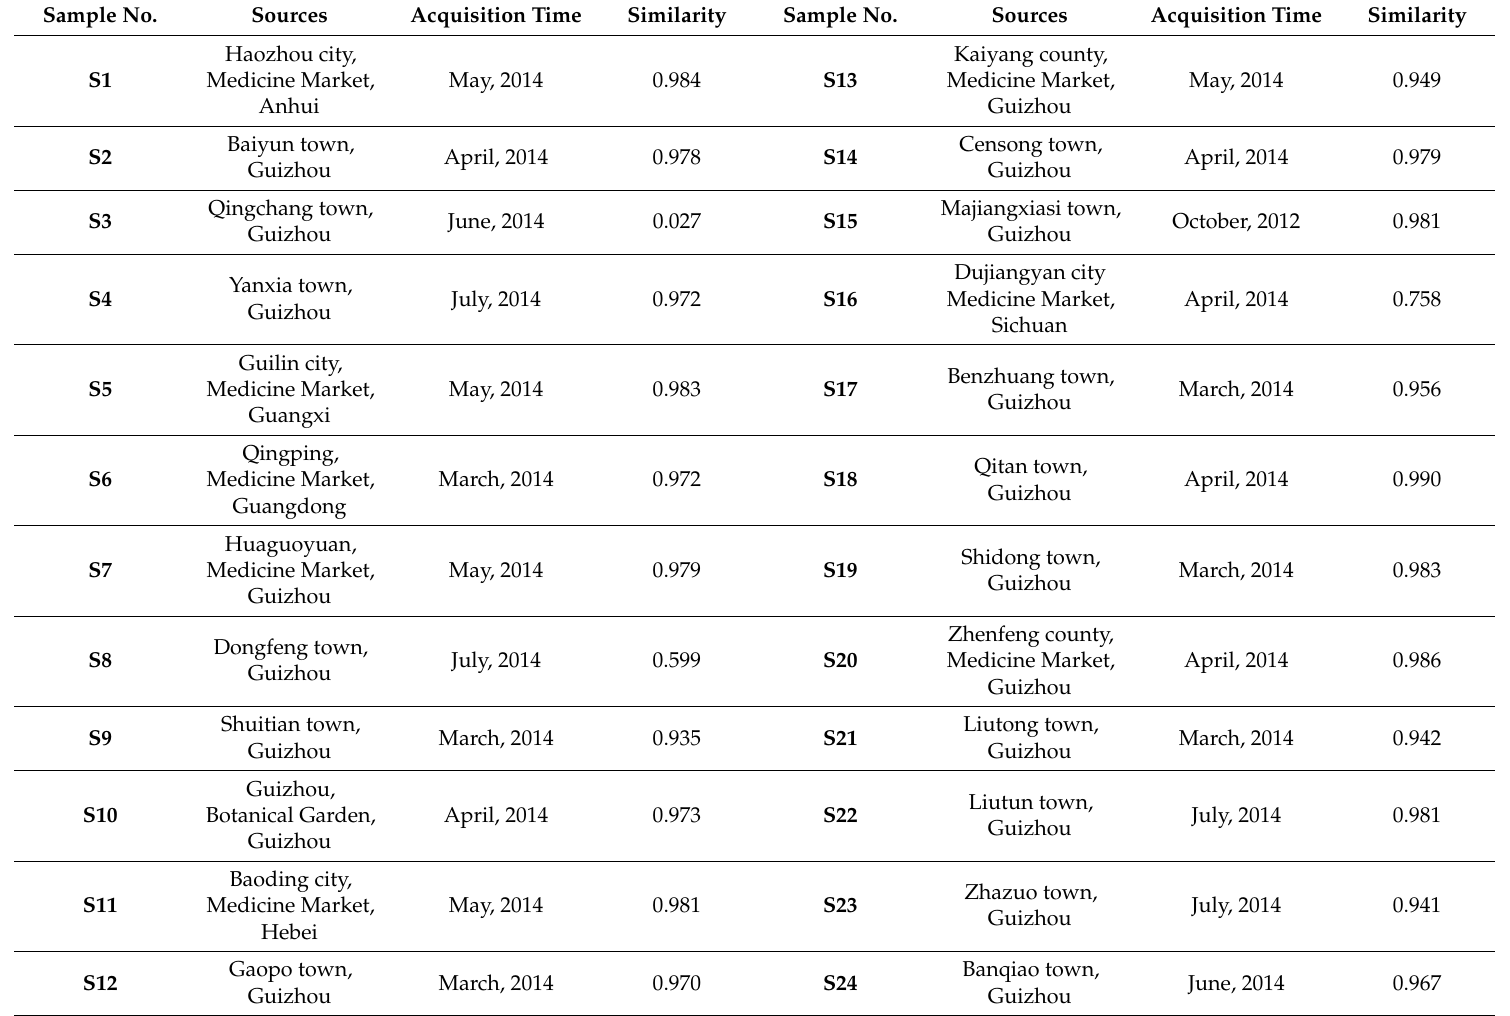
Table 1. Collected information and similarity of the